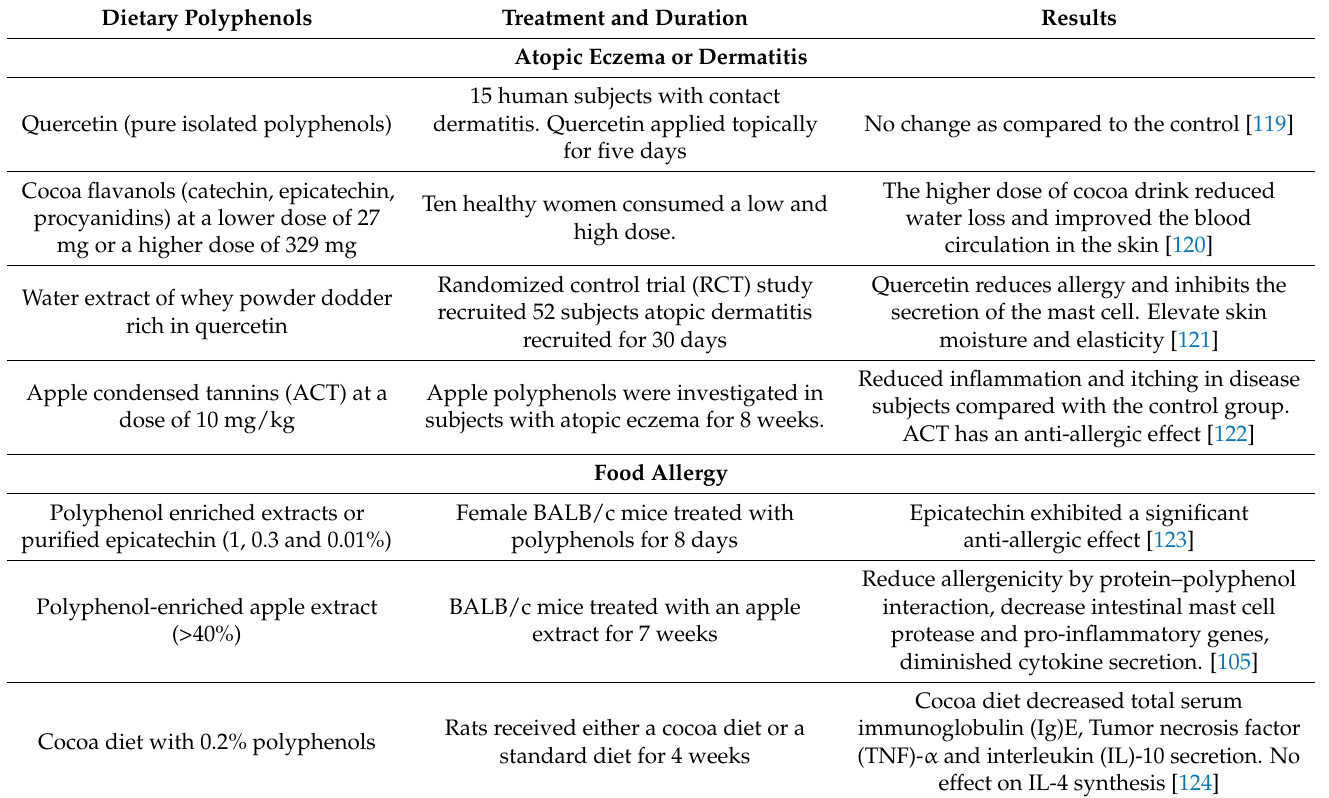
Table 2. Effect of dietary polyphenols on allergic